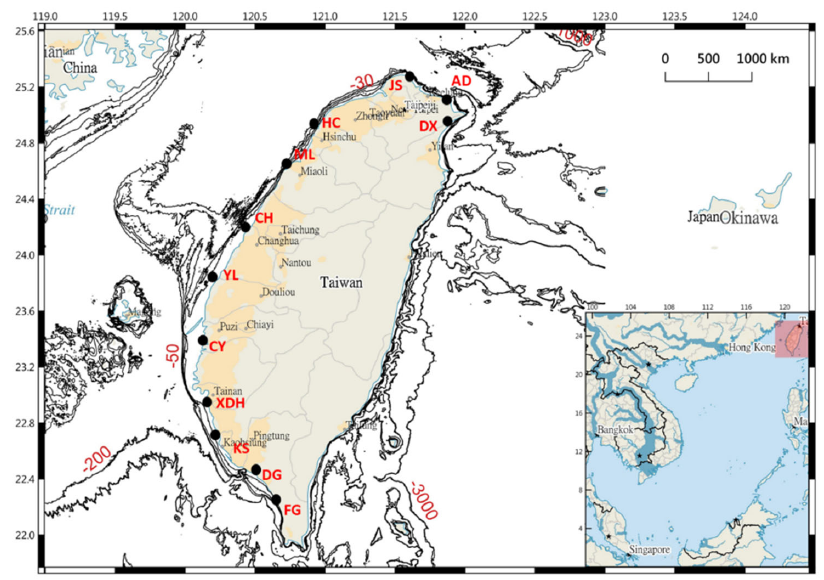
Figure 1. Sampling sites of Johnius species in Taiwan (Acronyms for sites: Daxi (DX); AoDi (AD), Jinshan (JS), Hsinchu (HC), Miaoli (ML), Changhwa (CH), Yunlin (YL), Chiayi (CY), Xingdaohe (XDH), Kaohsiung (KS), Donggang (DG), and Fenggang (FG). The red outlier numbers around Taiwan indicates the